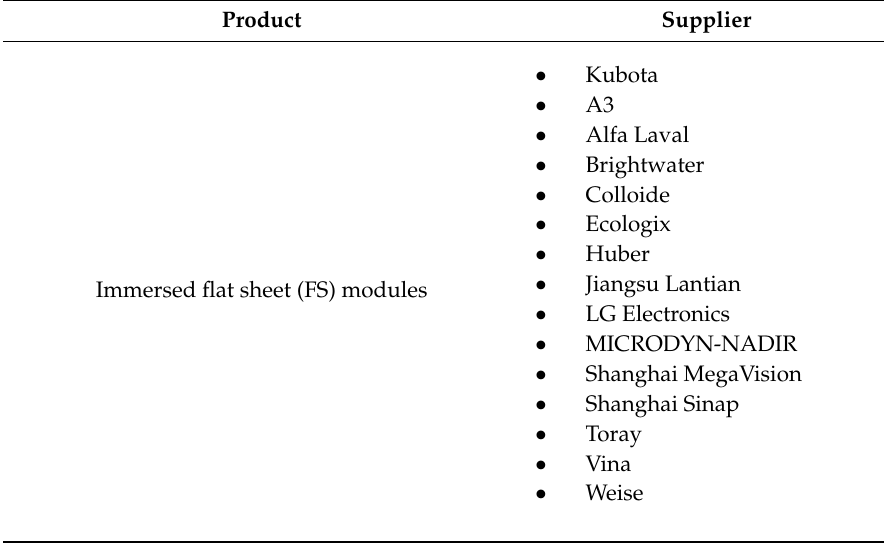
Table 4. MBR module